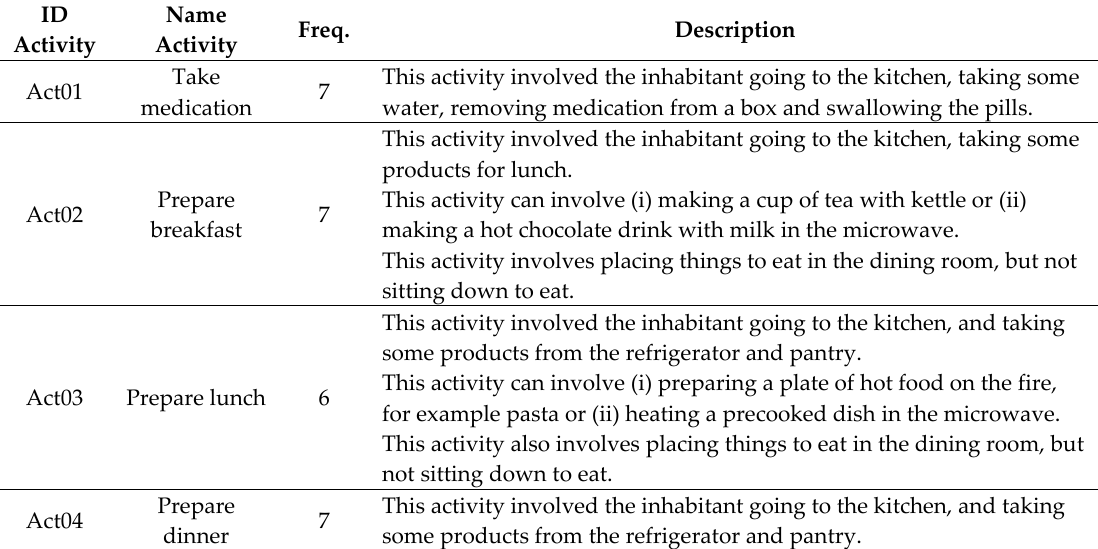
Table 1. Activities recorded in the UJA